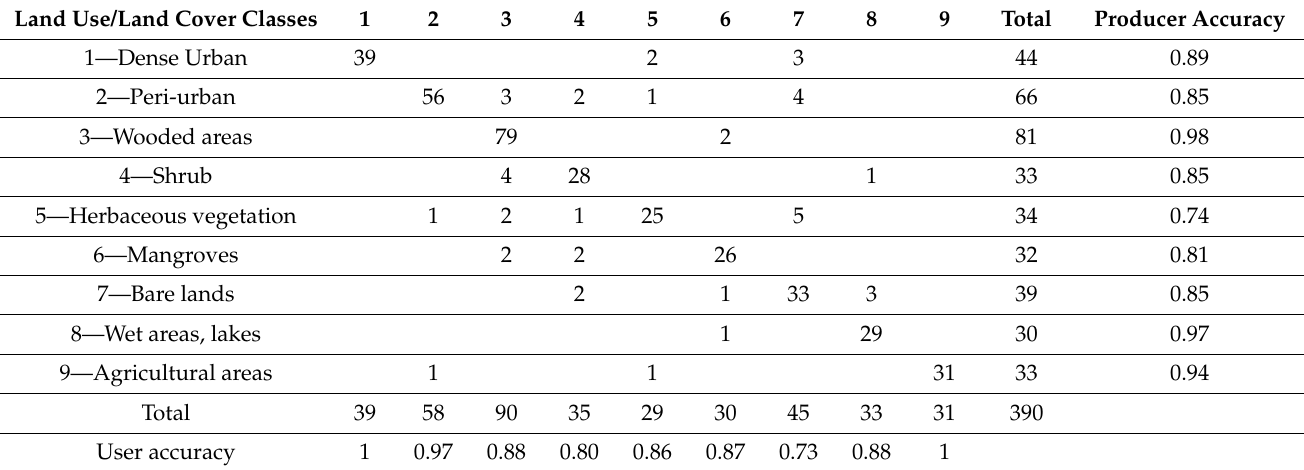
Table 2. Confusion matrix of the land use/land cover